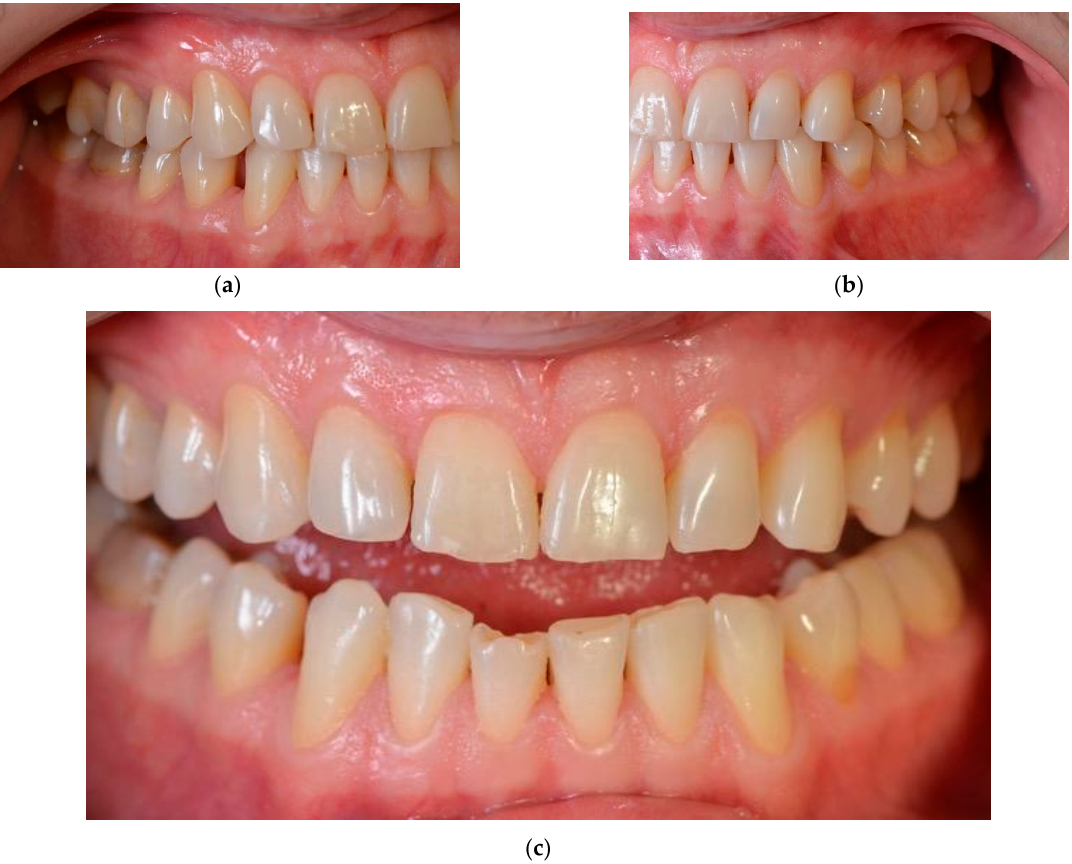
Figure 4. Intra-oral frontal and lateral views before treatment: ( a ) right lateral view; ( b ) left lateral view; ( c ) frontal view. Teeth appeal before treatment.